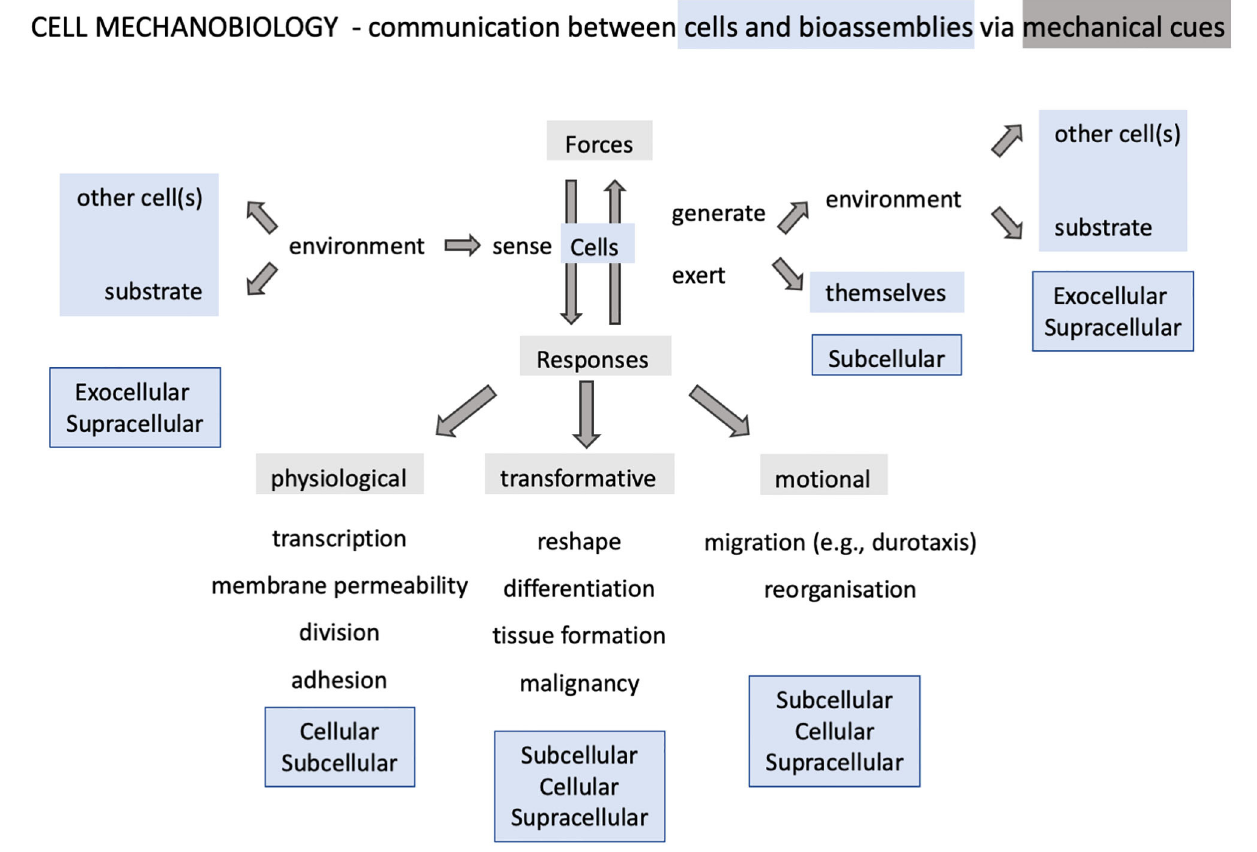
FIGURE 1 | Landscape of cellular mechanobiology. The discipline revolves about single cell behavior and encompasses phenomena involving supracellular, intracellular and exocellular